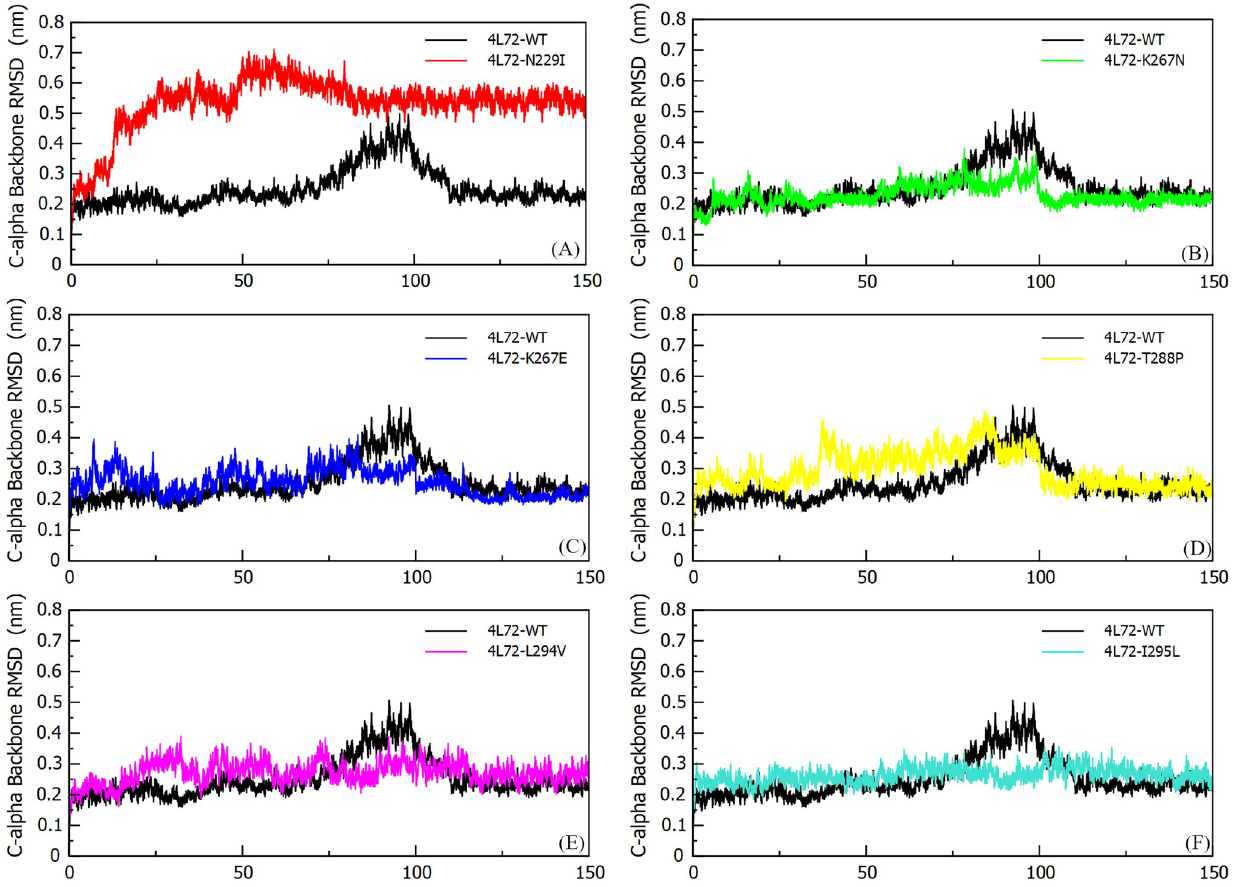
Fig 2. C α -Backbone root mean square deviation (RMSD) of the human DPP4 protein in complex with MERS-CoV S1 RBD protein, during 150 ns of the molecular dynamics simulation period. (a) RMSD 4L72-WT vs 4L72-N229I. (b) RMSD 4L72-WT vs 4L72-K267N. (c) RMSD 4L72-WT vs 4L72-K267E. (d) RMSD 4L72-WT vs 4L72-T288P. (e) RMSD 4L72-WT vs 4L72-L294V. (f) RMSD 4L72-WT vs